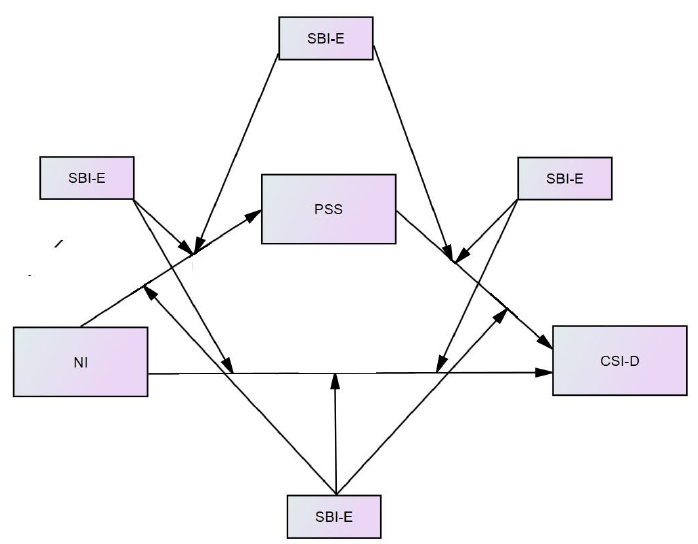
Figure A1. Possible moderated mediation models; Figure A2: Scatter plot and regression lines between PSS and NI scores based on level of equanimity.